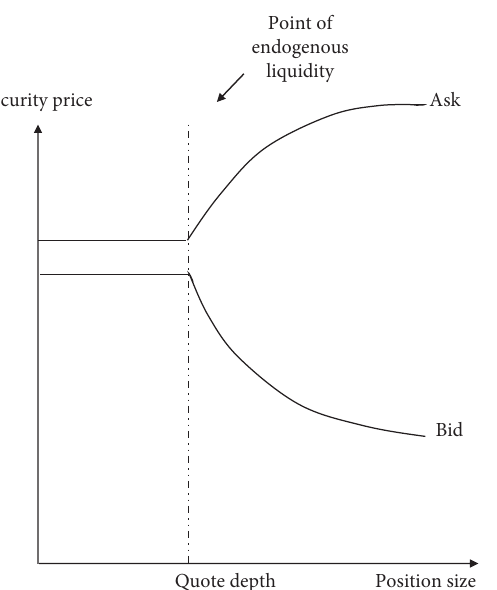
Figure 1: Relationship between position size and security